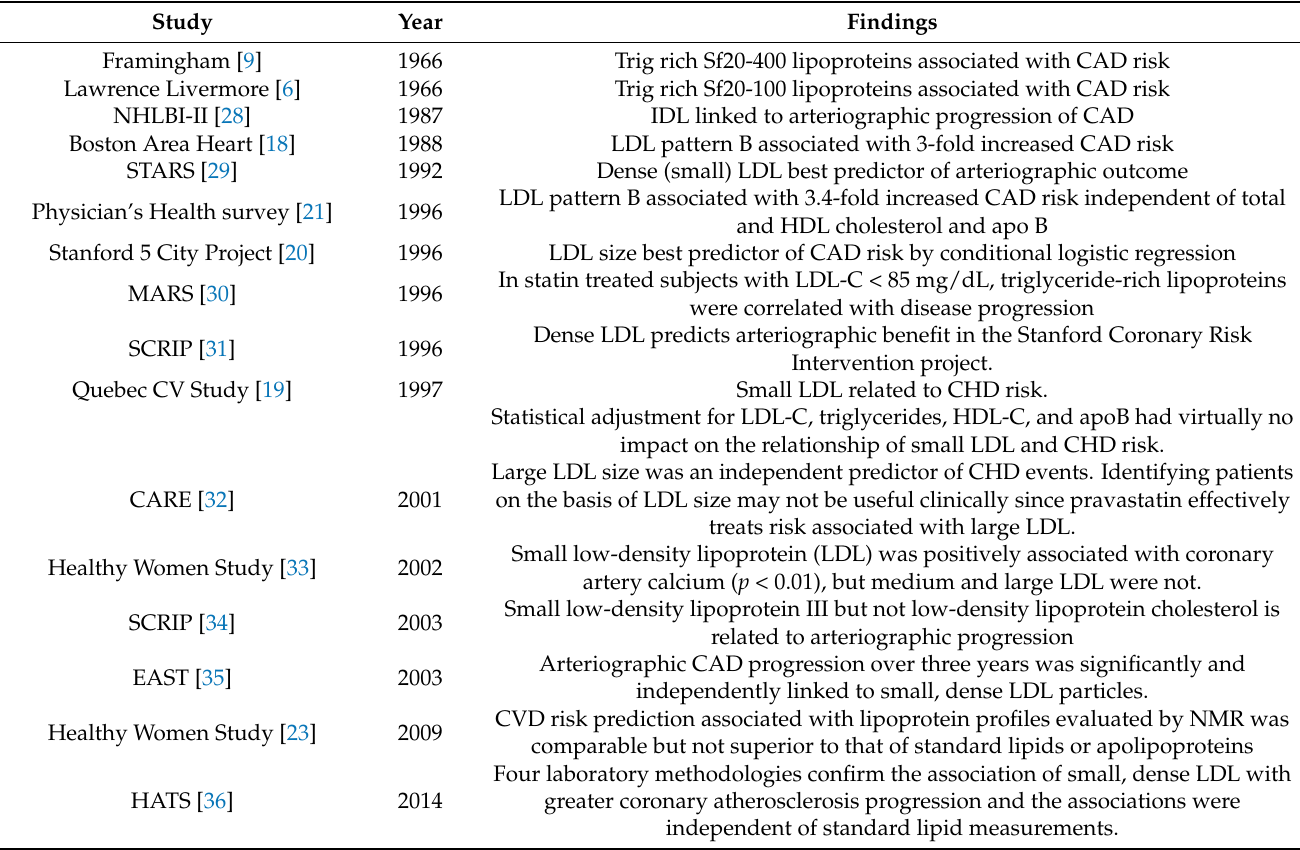
Table 1. Relevant clinical investigations that have contributed to understanding the role of small, dense LDL in cardiovascular risk ranked by date of